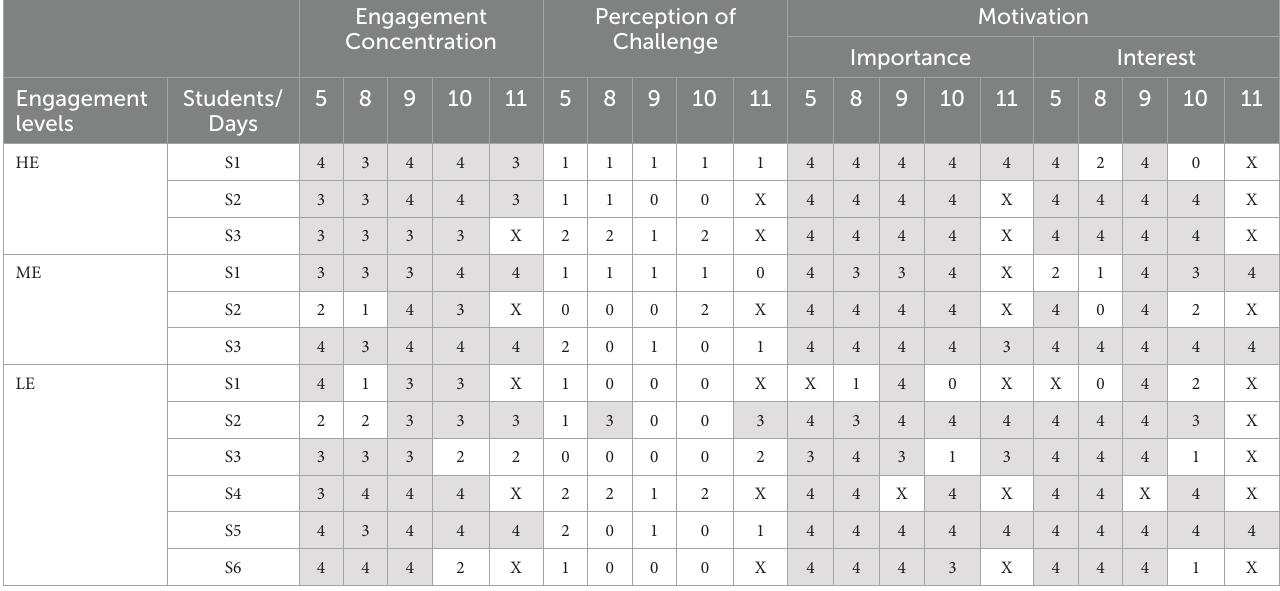
Engagement Perception of Motivation Concentration Challenge Importance Interest